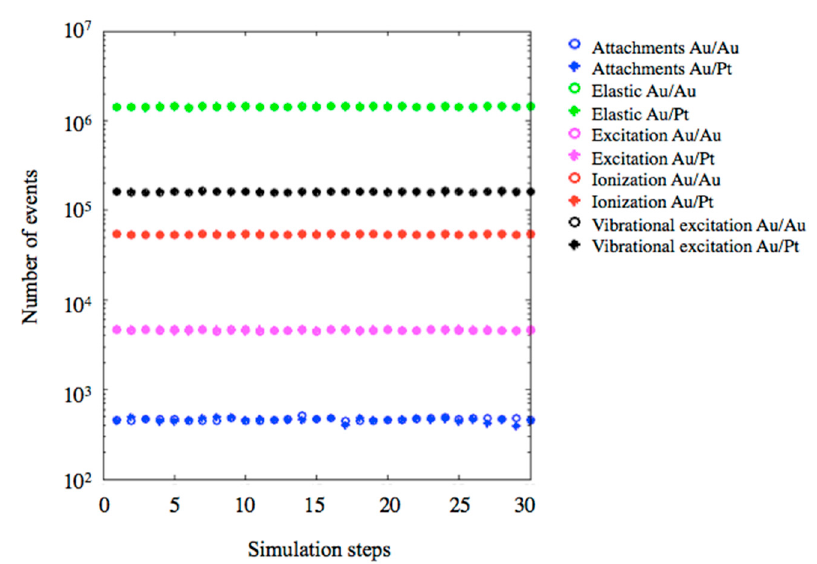
Figure 6. Type and number of scattering events calculated using the Geant4-DNA physical model for the interaction between the cobalt-60 radioactive source (1.25 MeV) and nanoparticles embedded in water. The simulation was performed with 3 × 10 8 incidents photons divided into 30 steps. The Au core / Au shell and Au core / Pt shell nanoparticles were simulated separately.